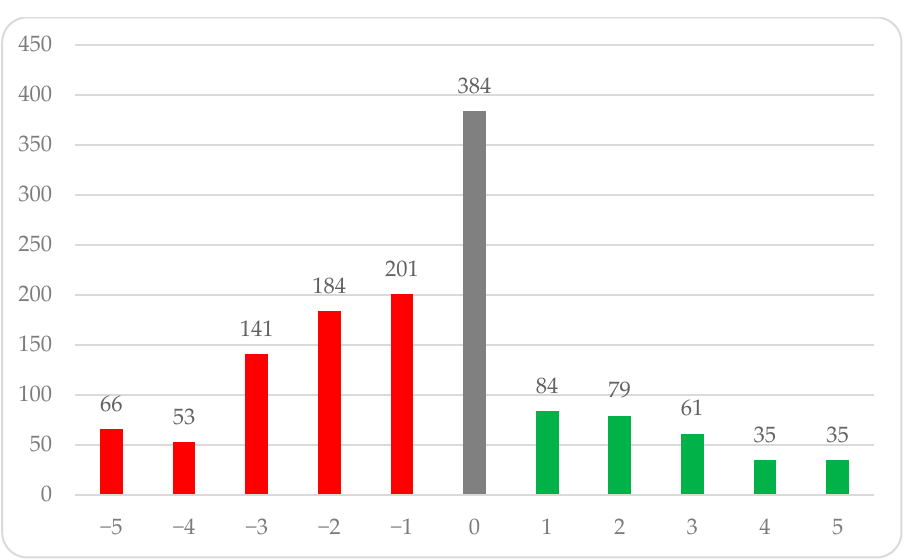
Figure 7. Respondents’ subjective assessment of the impact of the pandemic on sleep. Distribution of answers to the question.